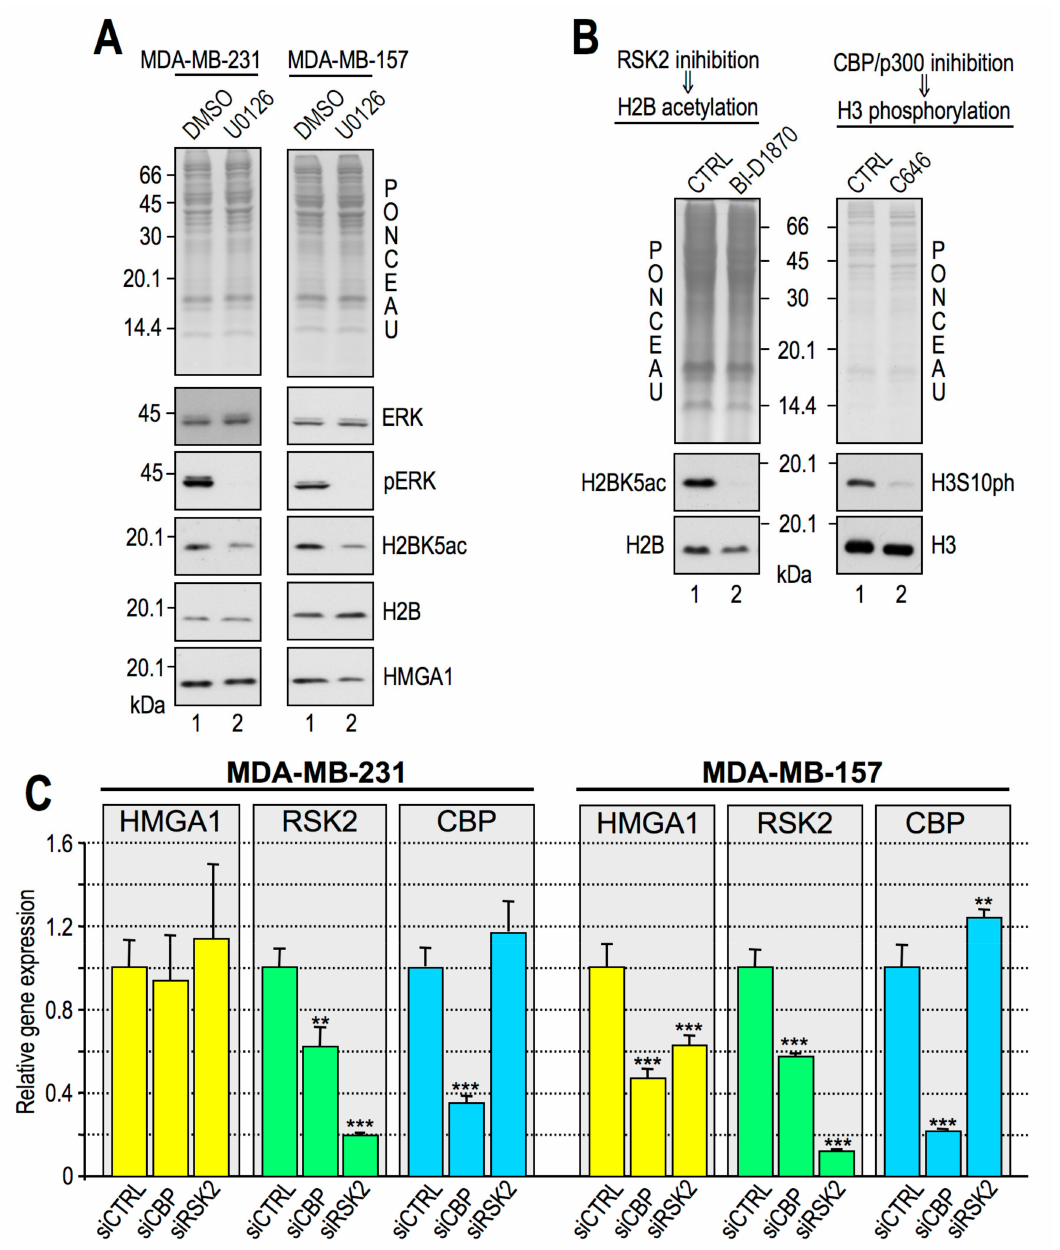
Figure 7. Ribosomal protein S6 kinase alpha-3 (RSK2) and CREB-binding protein (CBP) are interconnected epigenetic writers in MDA-MB–231 cells. Western blot (WB) analyses performed with MDA-MB–231 and MDA-MB–157 lysates. ( A ) Cells treated for 24 h with 10 µ M U0126 (lane 2) or dimethyl sulfoxide (DMSO) as a control (CTRL, lane 1). ( B ) MDA-MB–231 cells were treated with BI–D1870 and C646 (lane 2), and respective controls (CTRL, lane 1) and WB analyses were performed on cellular lysates. Representative red ponceau-stained membranes are shown as loading and quantification controls. Molecular weight markers (kDa) are indicated. All WB experiments were performed in triplicate, providing consistent results. Representative images are shown. ( C ) qRT-PCR analyses of MDA-MB-231 and MDA-MB-157 cells silenced for CBP (siCBP), RSK2 (siRSK2), or treated with a control small interfering RNA (siCTRL). The expression of HMGA1, RSK2, and CBP were analysed. Glyceraldehydes-3-phosphate dehydrogenase (GAPDH) was used as internal reference gene. Mean, standard deviations ( n = 3), and statistical significance ( t -test) are indicated (**: p < 0.01; ***: p <